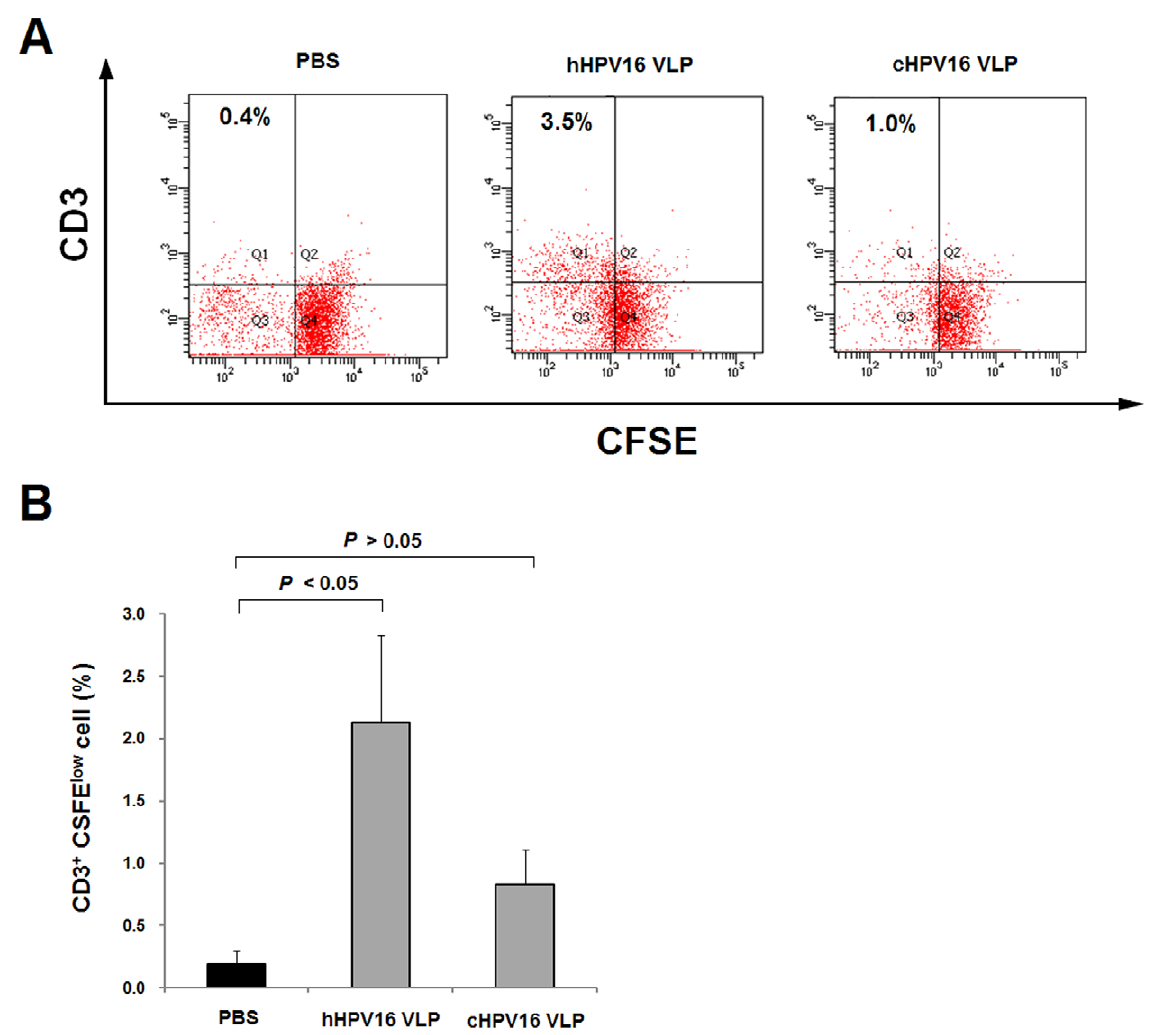
Figure 7. Invitro CD3 + cell proliferation measured using CFSE labeling. To measure HPV16 VLP-specific CD3 + cell proliferation, mice were immunized two times with 1000 ng of hHPV16 VLP or cHPV16 VLP at a two-week interval (protocol-3 in Table 2). The PBS-immunization group received 100 m l of PBS using same protocol described above. Ten days after the last immunization, mice spleens were isolated and labeled with CFSE. The CFSE-labeled spleen cells were re-stimulated with 10 m g/ml of HPV16 VLP (hHPV16 VLP and cHPV16 VLP in a 1:1 ratio) and cultured for 5 days. CD3 + cells were detected using anti-mouse CD3 PerCP-eFluor H 710 antibodies. Panel A is representative the flow cytometry results of three individual mice demonstrate the proliferation of CD3 + total live lymphocyte cells. To score proliferated CD3 + cells, total live lymphocytes were gated from forward and side scatter, and the upper-left segment of each graph was counted using FITC and PerCP eFluor scatter. Panels B presents the mean 6 SEM